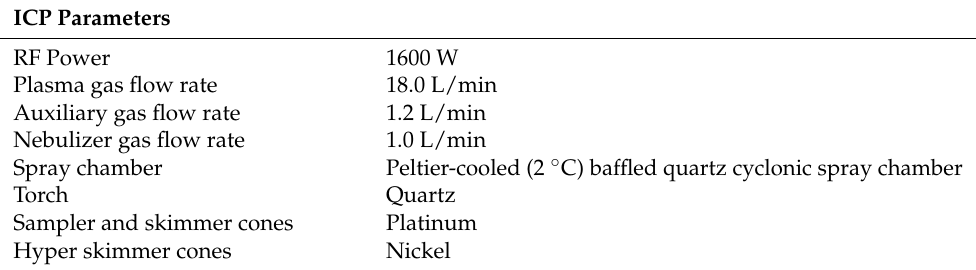
Inductively coupled plasma mass spectrometry (ICP-MS) operating conditions and acquisition